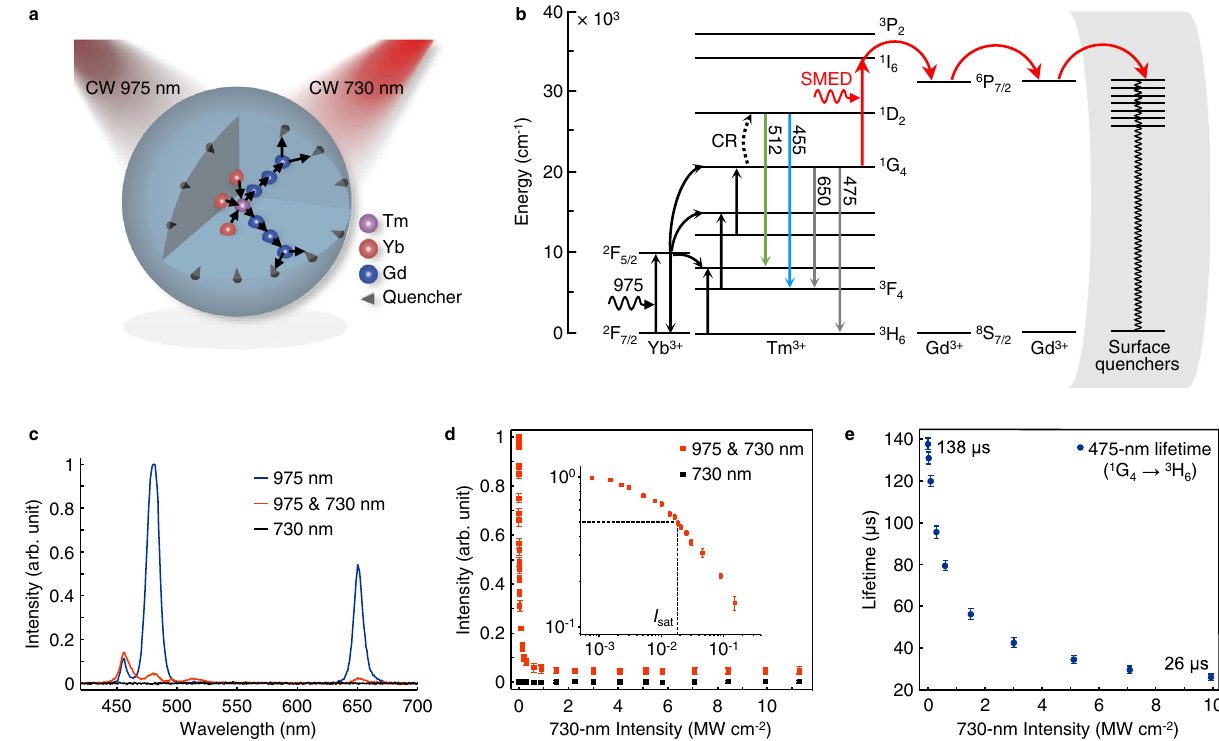
Fig.2|SMED-mediatedhigh-ef fi ciencyemissiondepletion.a Schematicdiagram oftheSMEDdepletionprocessandenergytransferpathwaysinNaGdF 4 :Yb/Tm(18/ 0.3%) nanoparticles. b Proposed SMED mechanism of upconversion emissions from the 1 G 4 state of Tm 3+ . c Upconversion emission spectraof NaGdF 4 :Yb/Tm (18/ 0.3%) nanoparticles illuminated with different lasers ( I 975 =21.7kWcm − 2 ; I 730 =3.01MWcm − 2 ). d Depletion intensity-dependence at a 975-nm excitation